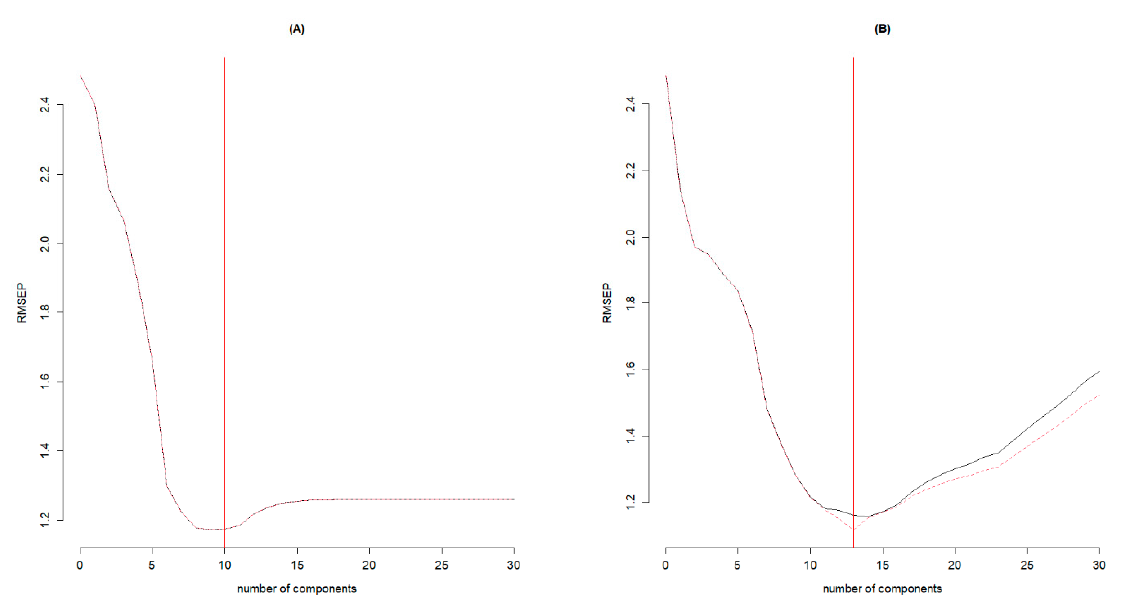
Figure 3. Plots of root mean squares error of prediction (RMSEP) against the number of components: ( A ) for partial least square regression (PLSR) using DA7250 spectral data, and ( B ) for PLSR using FT9700 spectral data. The red vertical line indicates the number of components used in the final models.